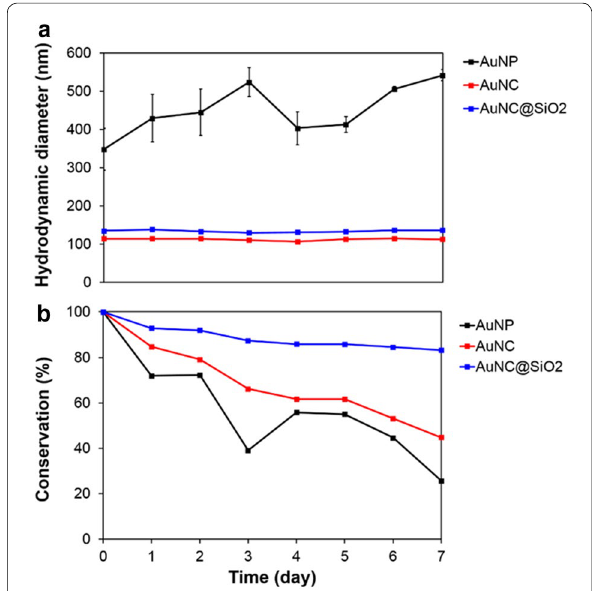
Fig. 2 Stability experiment of each Au nanoparticle type in PBS solution. a Size variation of each Au nanoparticle with time and